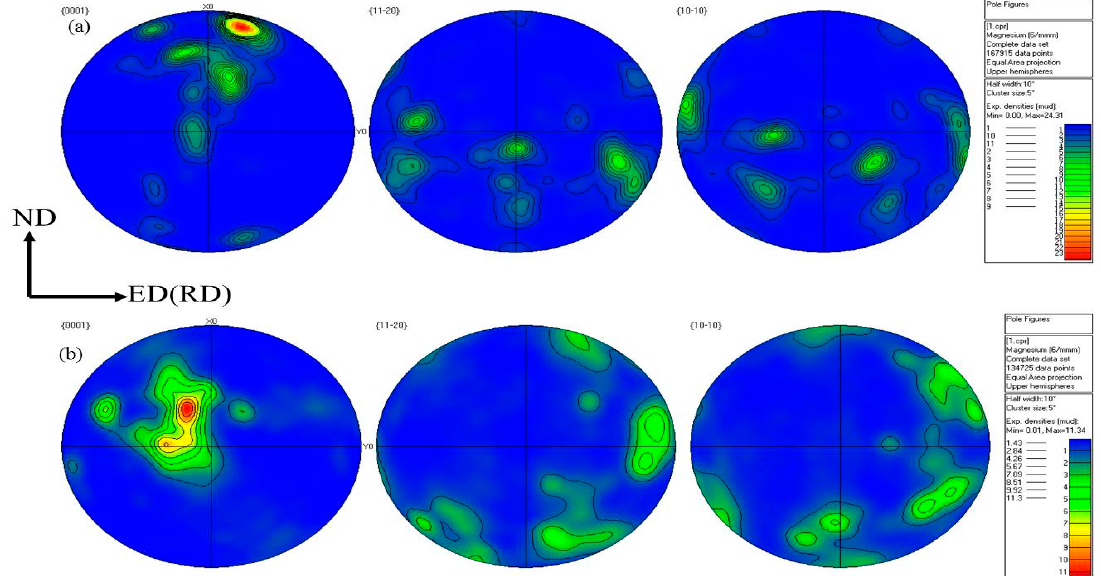
Figure 8. Electron backscattered di ff raction (EBSD) analysis results: pole figures of the as-rolled state ( a ) and extruded state ( b ).